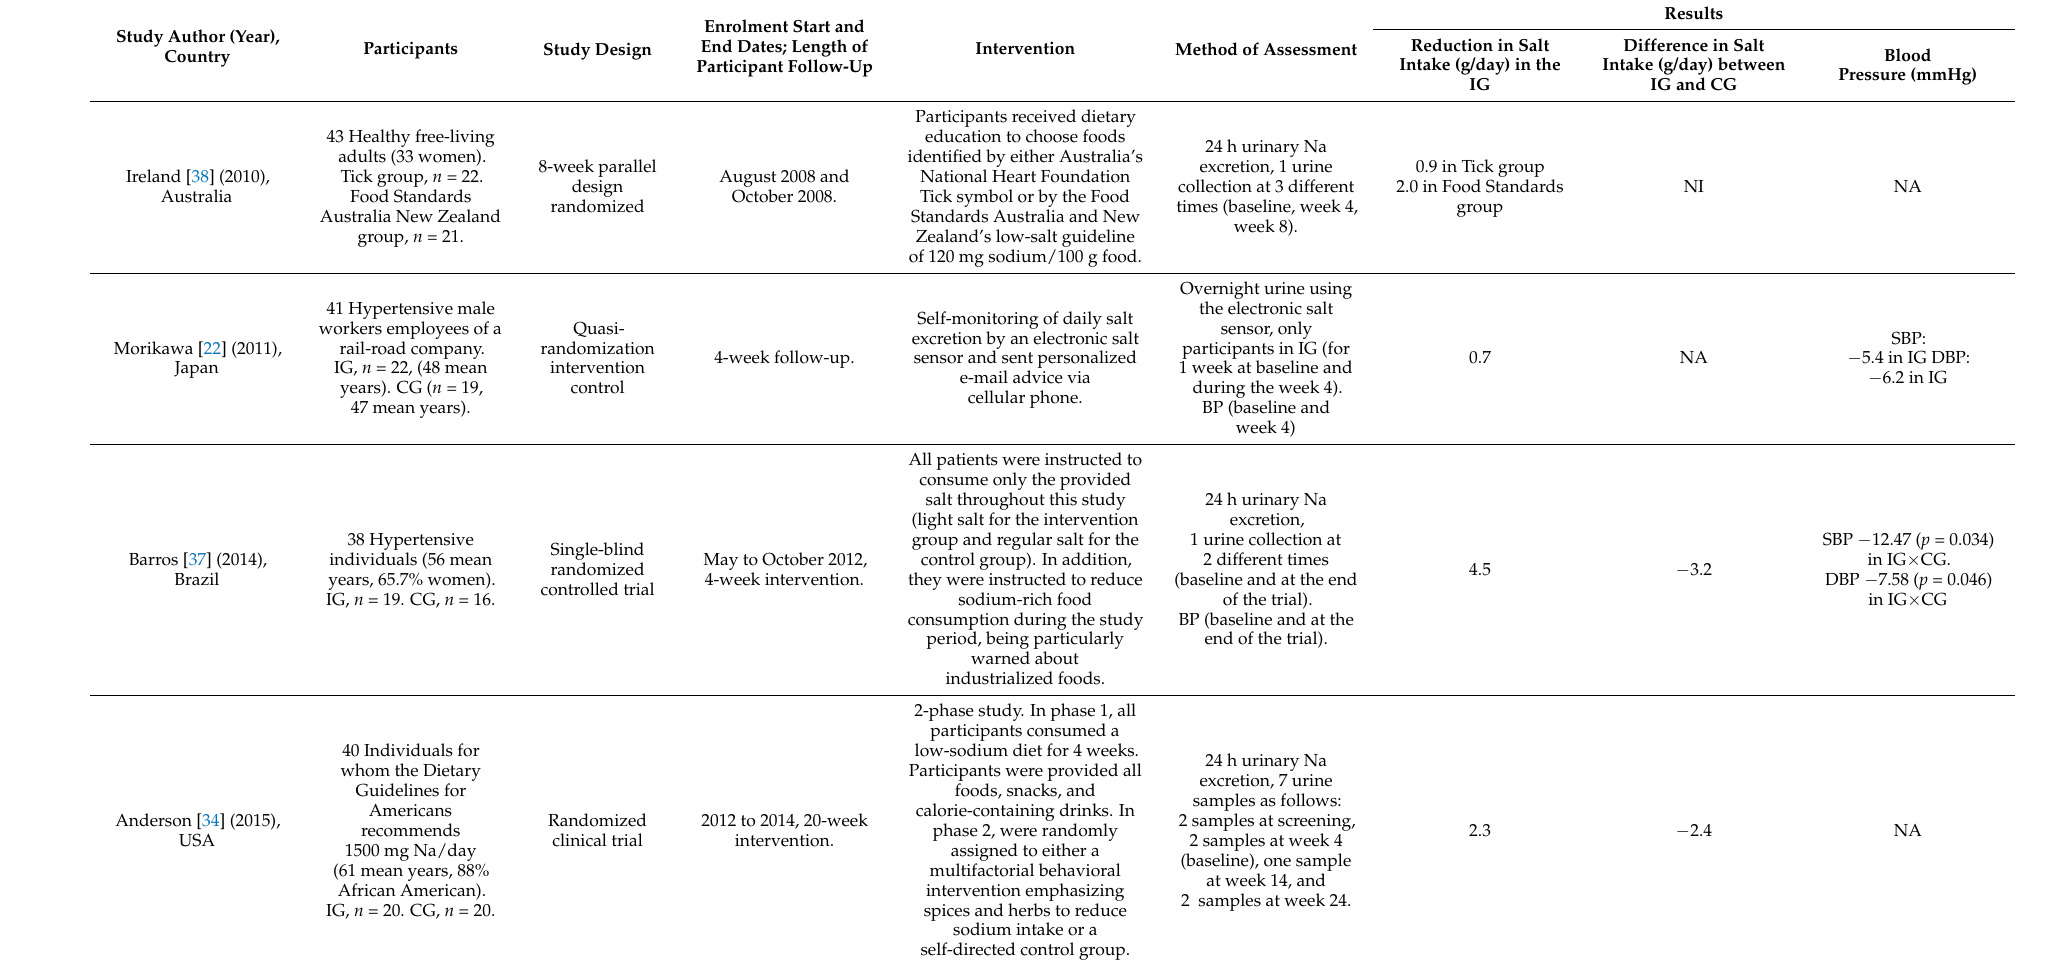
Table 1. Overview of characteristics of the included randomized